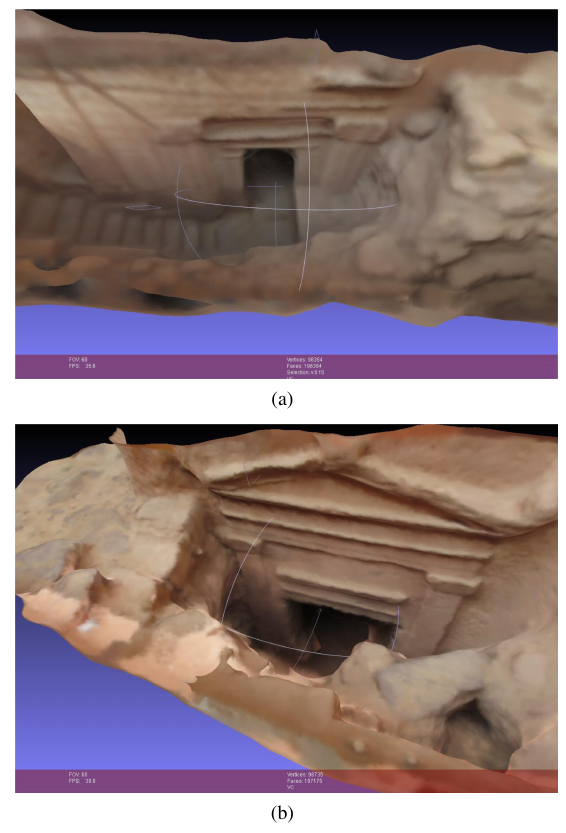
Figure 7. The 3D models of the doors, obtained after the compu- tation with MeshLab. (a) and (b) represent respectively the left and right doors of the underground area of the El-Khasneh During the image acquisition of the excavation, the existence of the iron grid and ground covering the doors, prevented a complete and whole surveying. For this reason, the two doors have been treated like separated elements. However, in order to produce a single element to be shared on line as a whole, a further step of conjunction of the two surveys was performed. To achieve this result, we identified some tie points between the two point clouds.